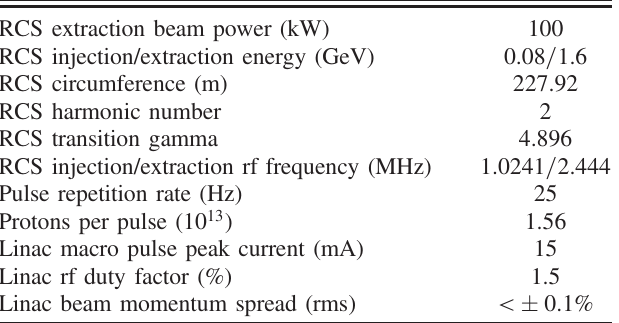
TABLE I. Main parameters of the CSNS accelerator complex at Phase